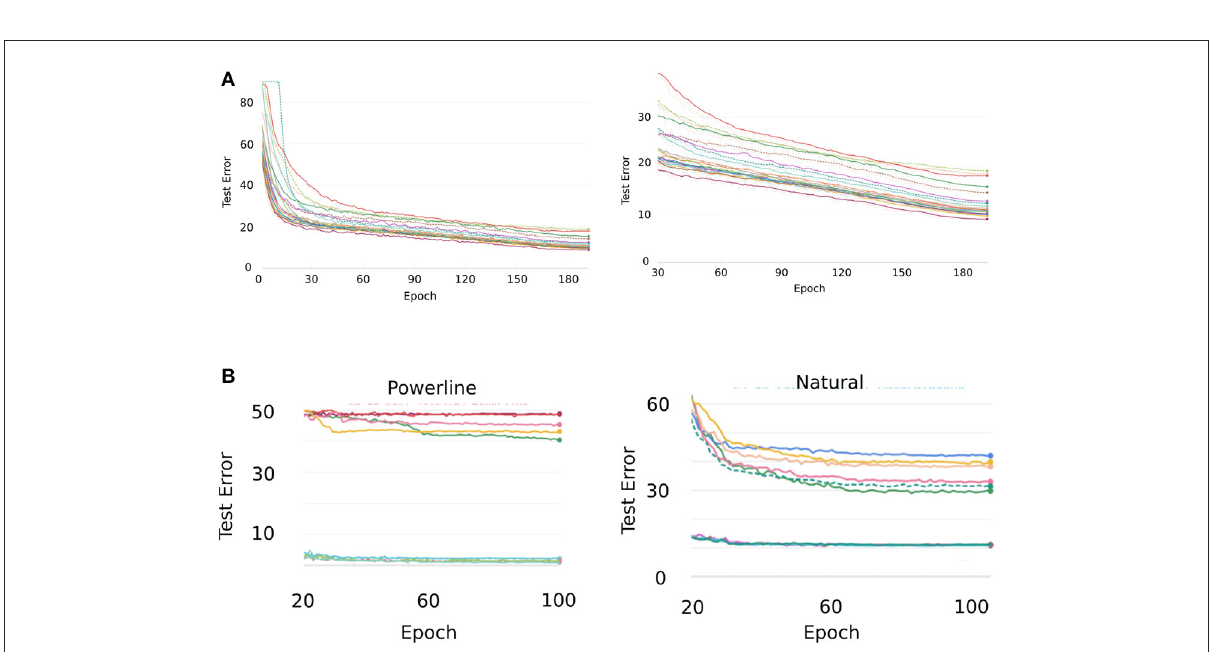
FIGUREA2 (A) Cifar10 test error curves of 20 randomly sampled architectures trained over 200 epochs (left). The same error curves but cut to epochs 30–200. (B) Test error curves of the five best and five worst models on Powerline and Natural, respectively, when training is continued to epoch